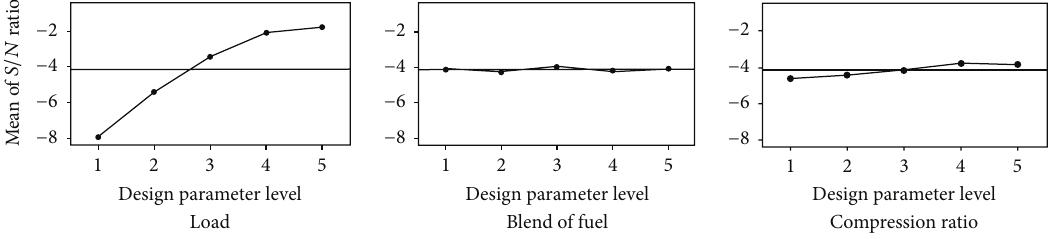
Figure 3: The main effect plots for 𝑆/𝑁